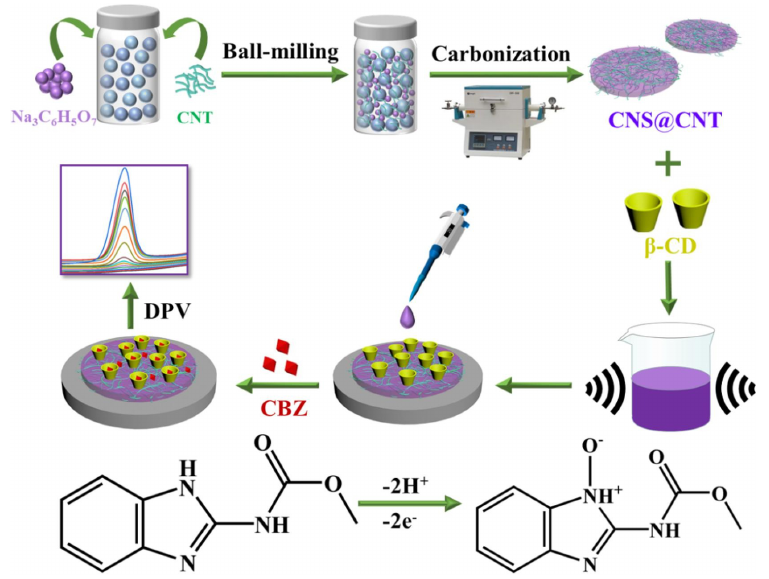
Figure 10. Schematic illustrating the fabrication steps of carbendazim sensor. Reprinted with permission from Ref.